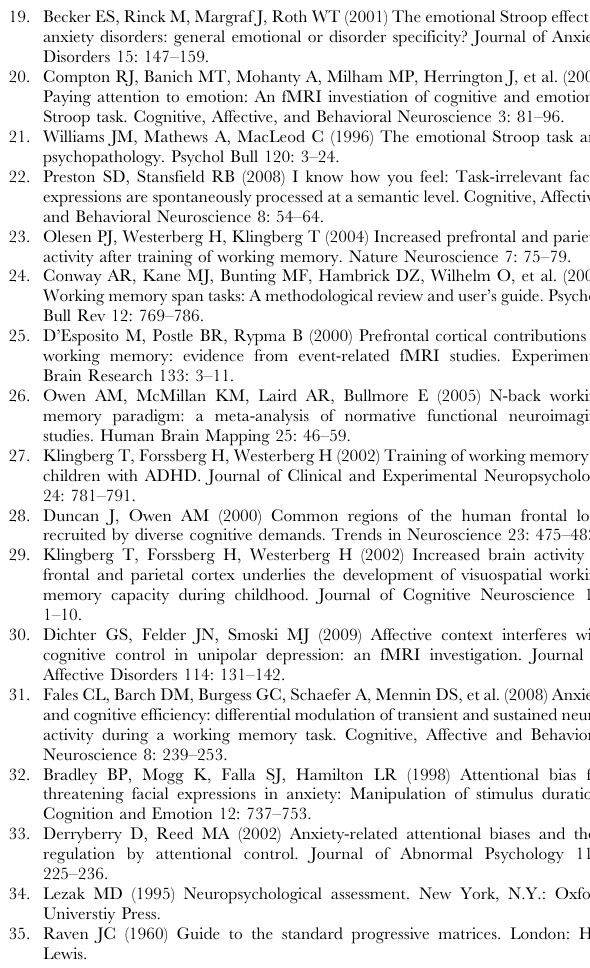
Table S1 Mean pre- and post-training scores on the digit span task for the combined training group and